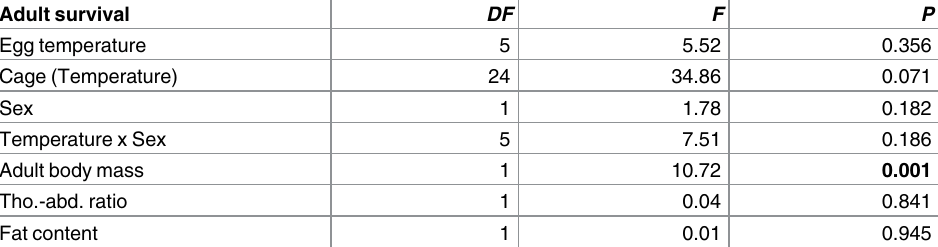
Table 2. Results of a nominal logistic regression for the effects of egg temperature (fixed), cage (nested within temperature; random), sex (fixed), adult body mass, thorax-abdomen ratio and abdo-